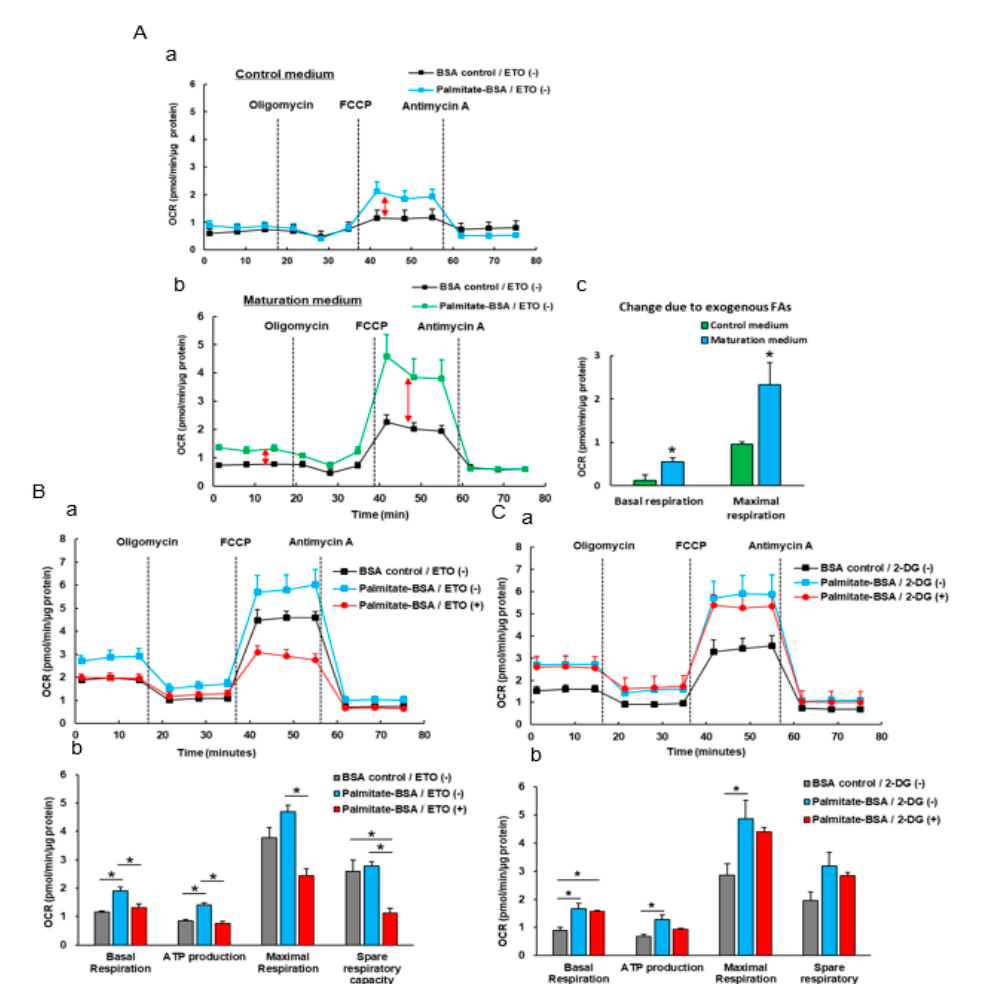
Figure 5. The effect of exogenous fatty acids (palmitate) pre-treatment on the OCR of 1013 iPSC-derived CMs (day 34) cultured with either control medium or maturation medium. ( A ) The changed basal and maximum OCR in both control and matured iPSC-CMs in response to exogenous palmitate. iPSC-CMs were pretreated with bovine serum albumin (BSA; as control), palmitate, or etomoxir (ETO, a specific irreversible inhibitor of carnitine palmitoyltransferase 1 inhibitor). Basal and maximum respiration capacity was significantly increased in the matured iPSC-CMs compared to control cells due to the utilization of palmitate. Pretreatment with palmitate-BSA (blue) resulted in the increased basal and maximal respiration in non-matured iPSC-CMs compared with BSA alone treatment group (black) (a). Matured iPSC-CMs exhibit the greater increase in both basal respiration (4.4 fold higher vs. non-matured iPSC-CMs) and maximal respiration (2.5 fold higher vs. non-matured iPSC-CMs) in response to palmitate-BSA (blue) (b and c), indicating the stronger ability to oxidize exogenously added palmitate in the matured iPSC-CMs. n = 4 * p < 0.05. ( B ) The effect of ETO on the OCR of matured iPSC-CMs pre-treated with BSA or palmitate. Representative OCR traces of iPSC-CMs pre-treated with BSA or palmitate together with or without ETO in response to oligomycin, FCCP, and antimycin A (a). ETO completely inhibited the